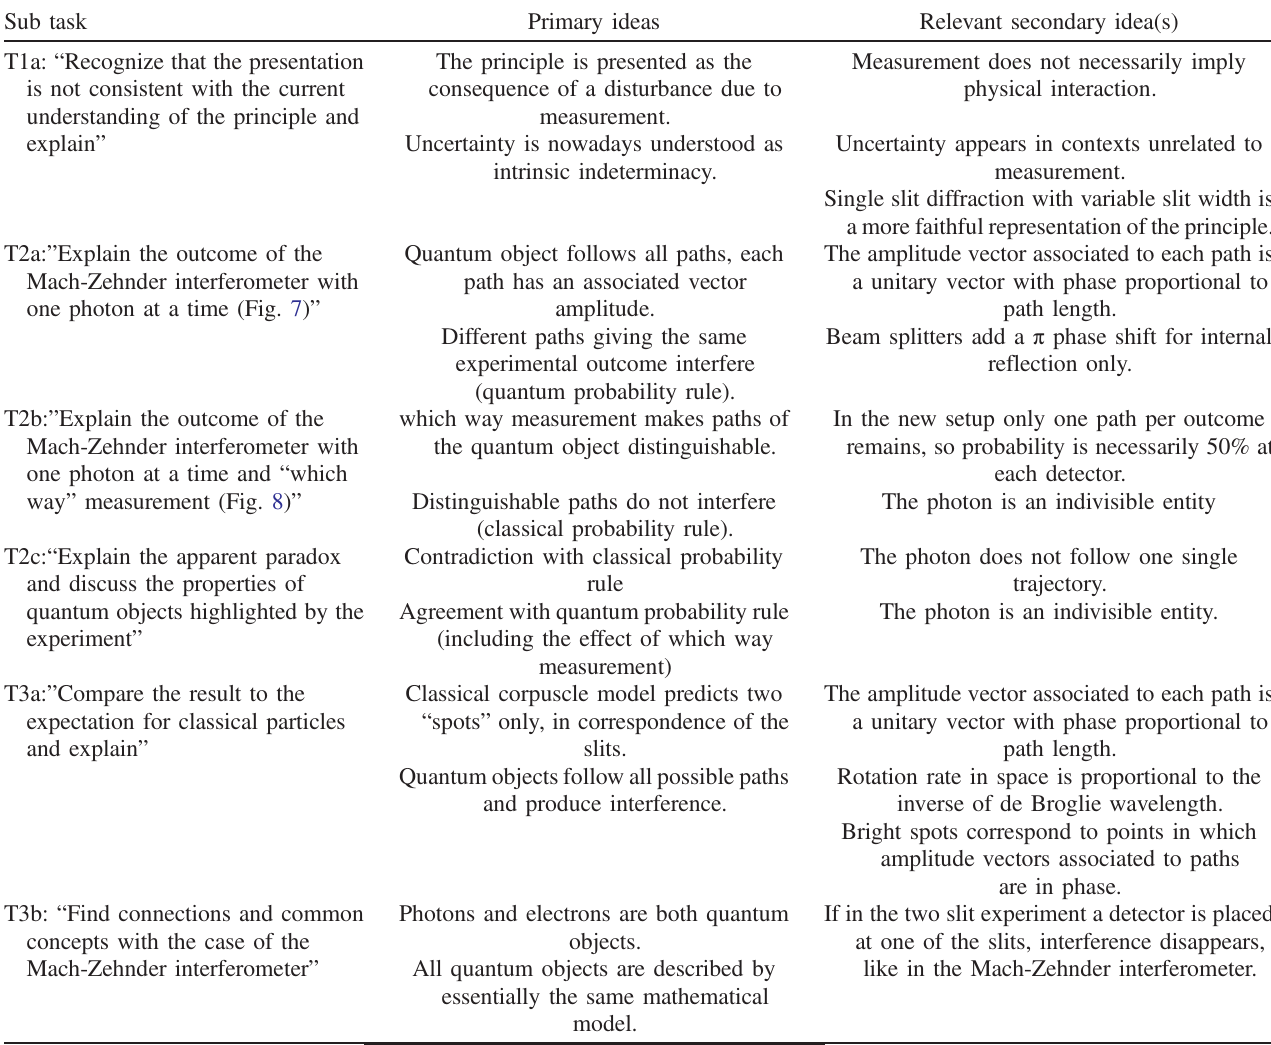
TABLE III. Relevant ideas, divided into “ primary ” and “ secondary, ” which have to be elicited and connected by students in order to provide a scientifically valid argument for each